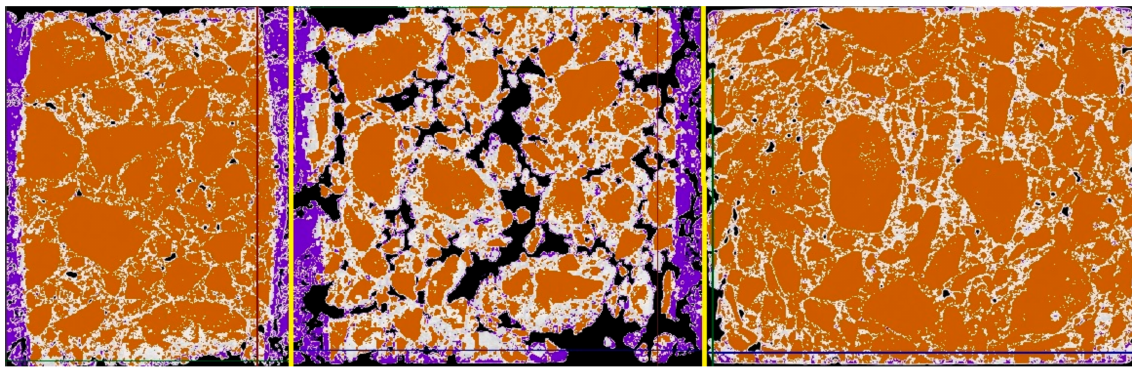
Figure 16. Edge specimen view.